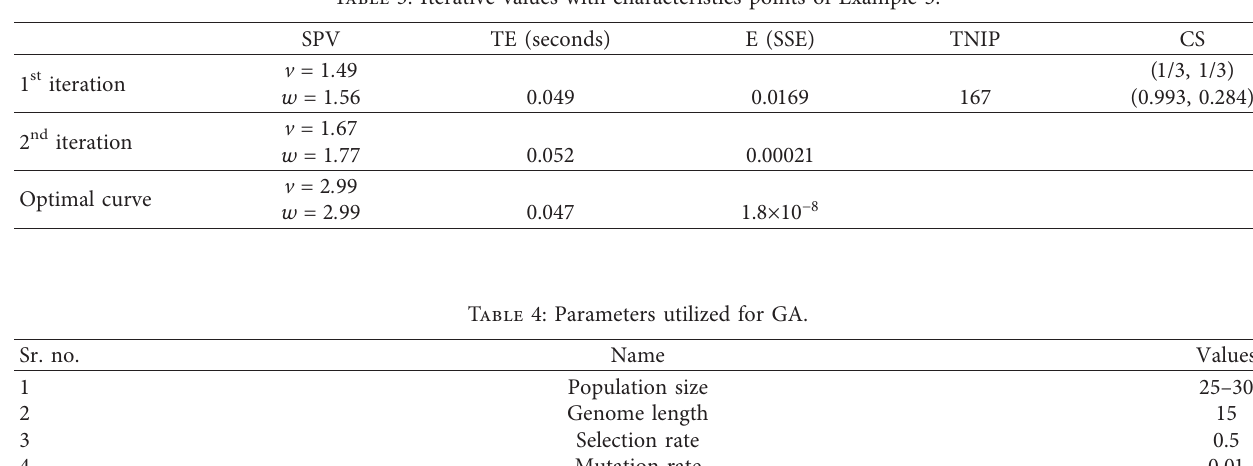
Table 3: Iterative values with characteristics points of Example 3.